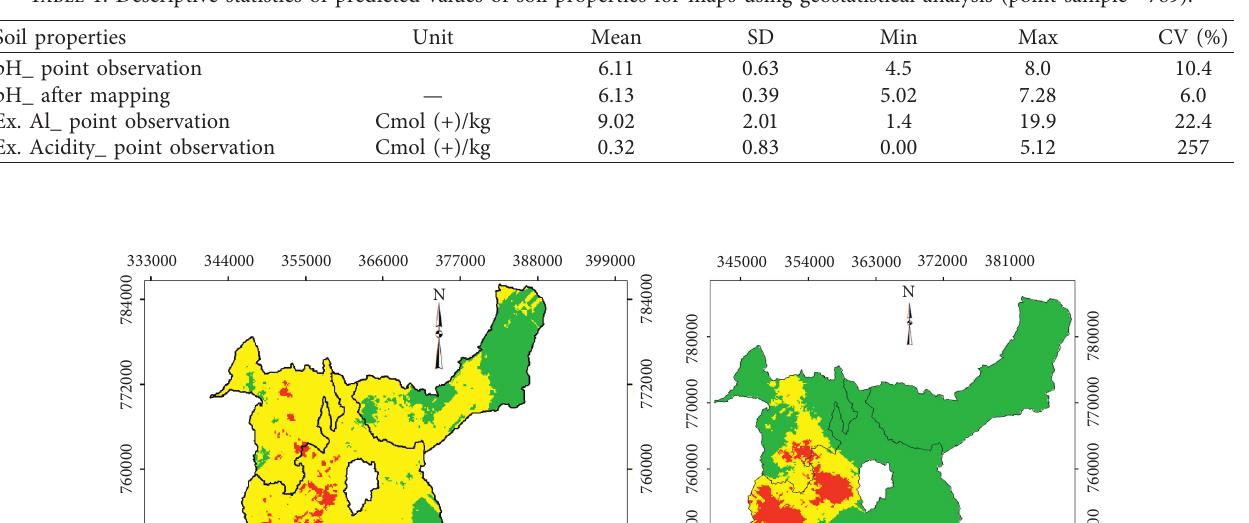
Table 1: Descriptive statistics of predicted values of soil properties for maps using geostatistical analysis (point sample �